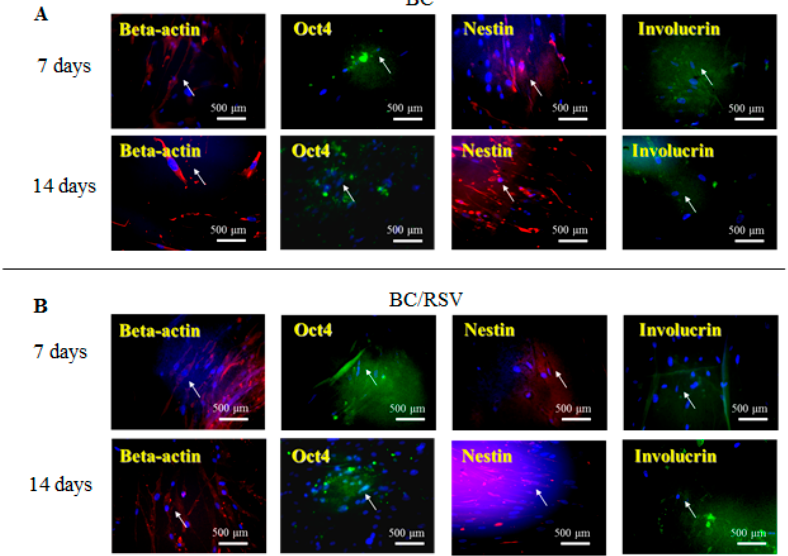
Figure 6. Representative images showing BC and BC/RSV scaffold biocompatibility with hASCs. ( A ) BC and ( B ) BC/RSV scaffolds. Images are of formalin-fixed, frozen, and immunostained stem cells for OCT4, nestin, and the keratinocyte-differentiation marker involucrin. β -actin was used as an internal staining control. White arrows indicate positive antibody expression in the scaffold. Nuclei were counterstained with Hoechst 33342 (blue). Scale bar = 500 μ m.